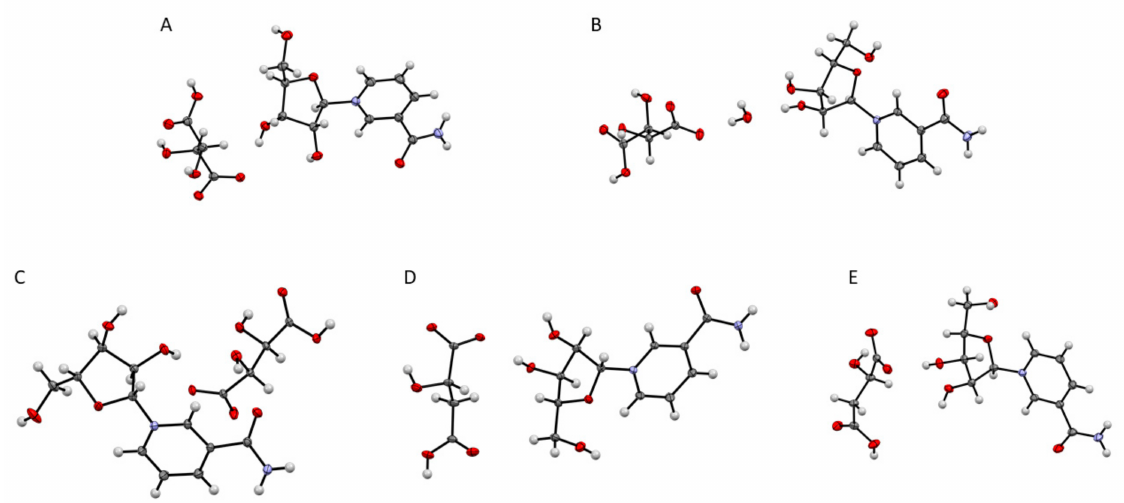
Figure 3. Displacement ellipsoid representations at 50% probability of: 11a ( A ) obtained by vapor diffusion; 11b ( B ) and 12 ( C ) obtained by controlled cooling; 13 ( D ) and 14 ( E ) obtained by thermal crystallization and addition of an